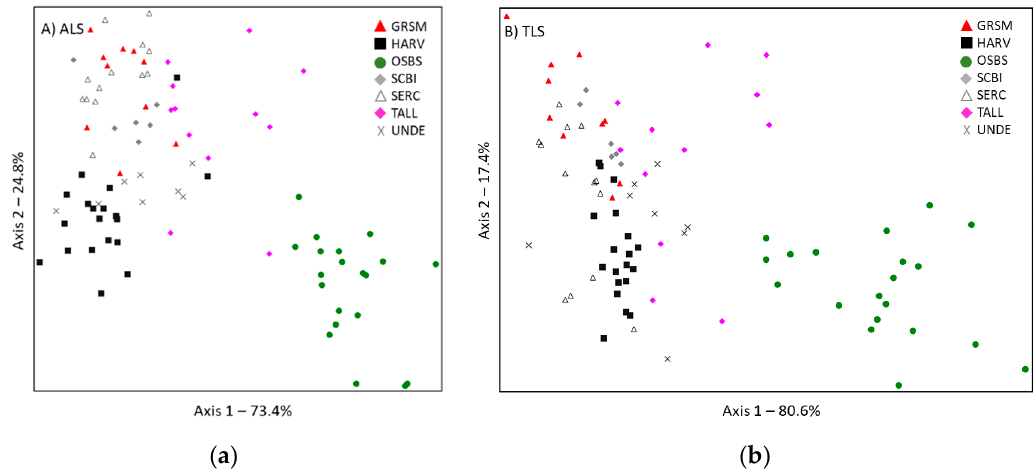
Figure 4. Non-metric multidimensional scaling ordination, illustrating variation in multivariate classification of plots across seven forest sites from structural diversity as measured using ( a ) aerial laser scanning (ALS) and ( b ) terrestrial laser scanning (TLS). Site ID abbreviations can be found in